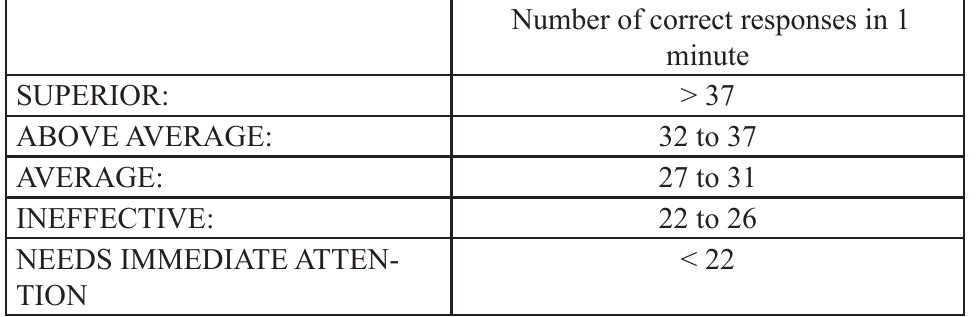
Right hand time in seconds